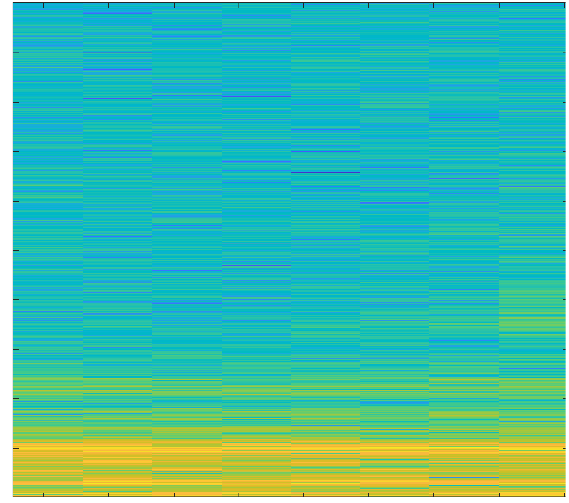
Figure 12. Hardwood, New Tool, 1 mm depth-of-cut.